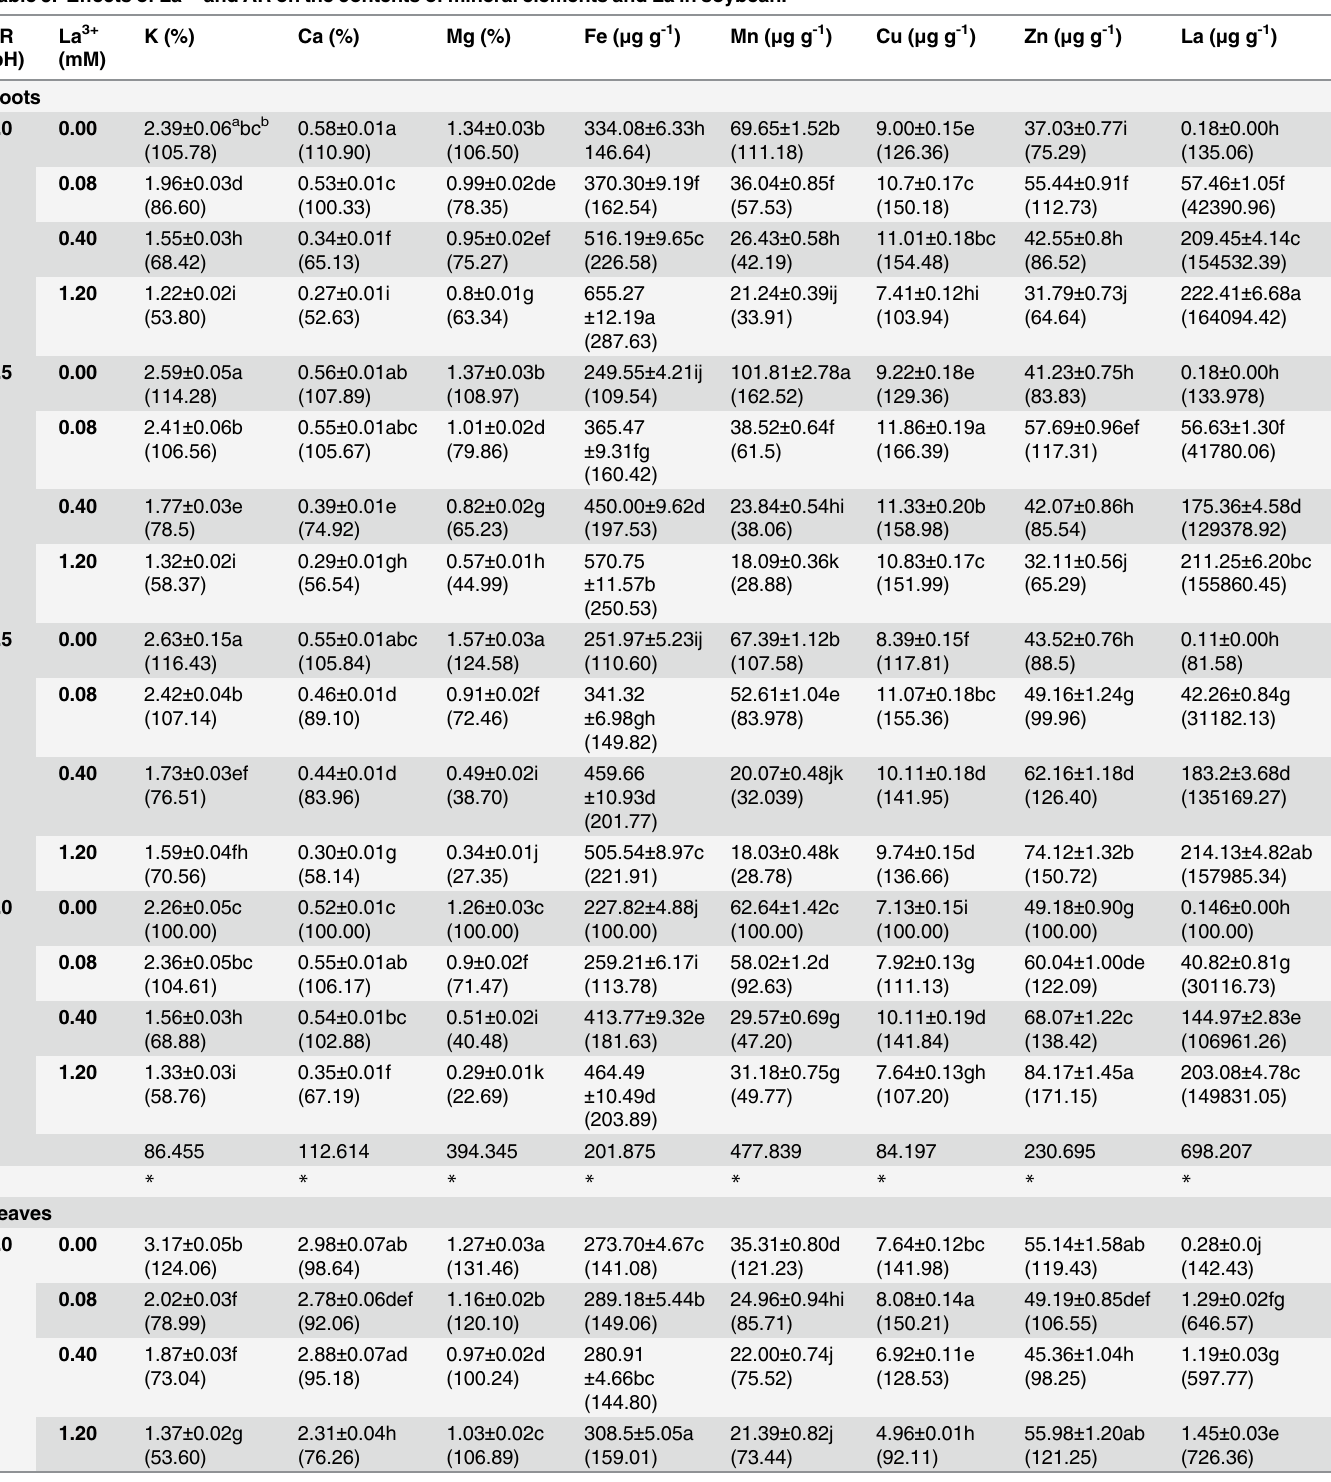
Table 5. Effects of La 3+ and AR on the contents of mineral elements and La in